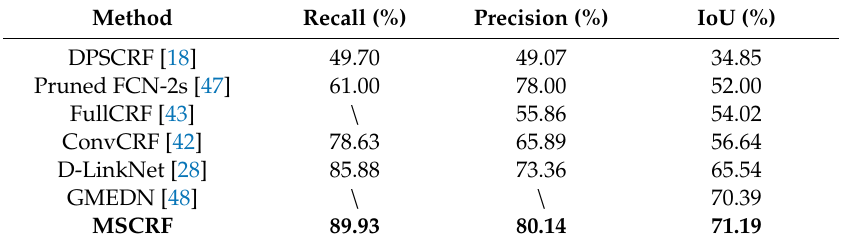
Table 2. Quantitative evaluation of buildings extracted from the Massachusetts dataset.